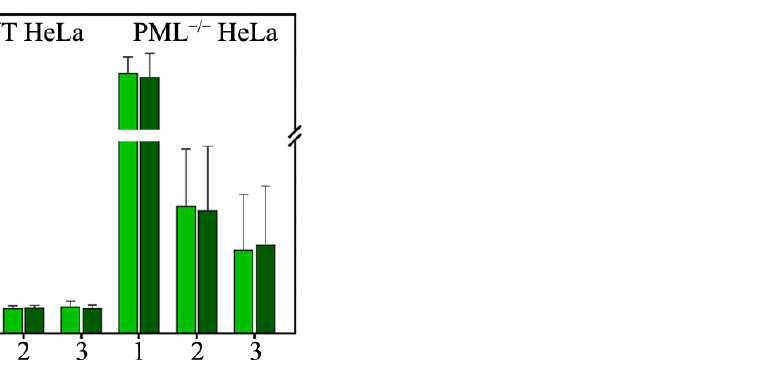
knockout HeLa cells.